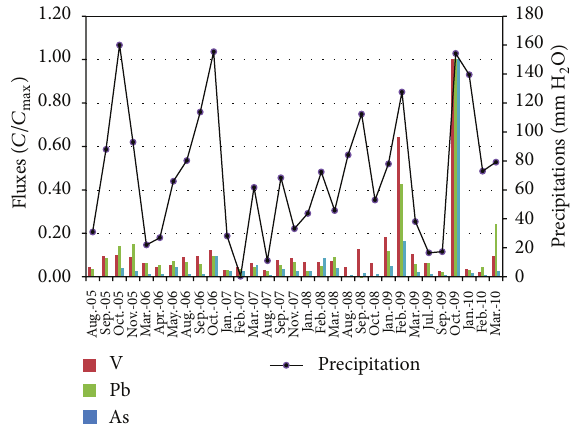
Figure 3: Average depositions of organic micropollutants for deposimeters D1, D2, D3, and D4 from January 2005 to May 2006.